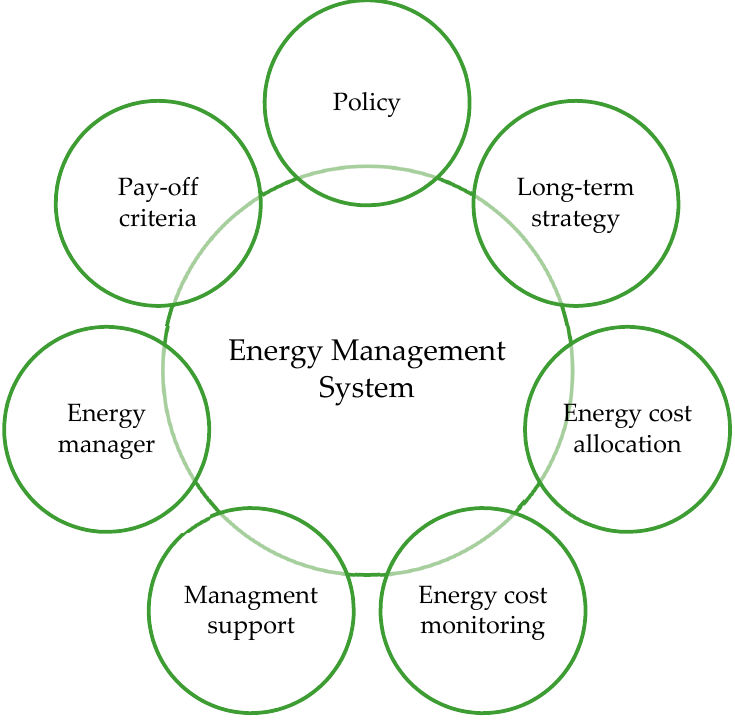
Figure 5. Criteria for a successful energy management system [11,12,55].